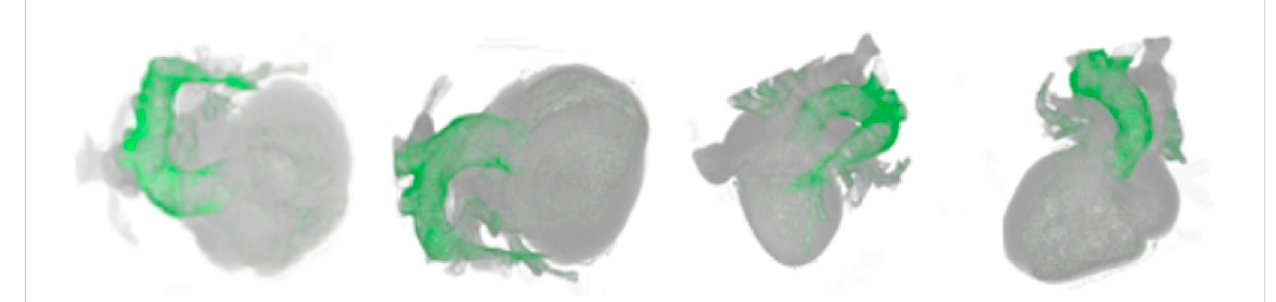
FIGURE 2 Rendering result of the outer wall of arterial vessels from different viewpoints.